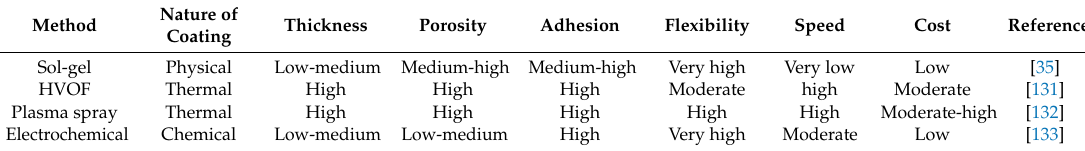
Table 3. A qualitative comparison of properties of different deposition processes.